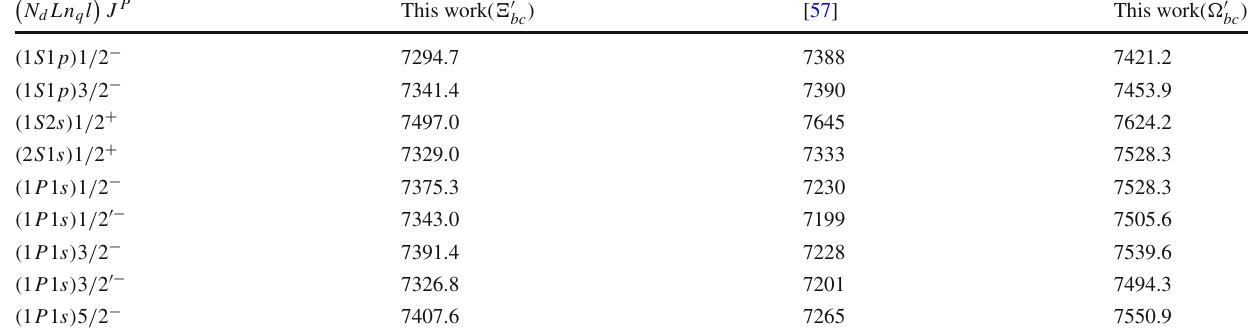
Table 16 Mass spectra of (cid:2) (cid:2) the binding energy shift(vanishes in 1S1s wave) in Table 9 and its splittings in Sect. 3 with the couplings given in Sect. 4 (cid:9)